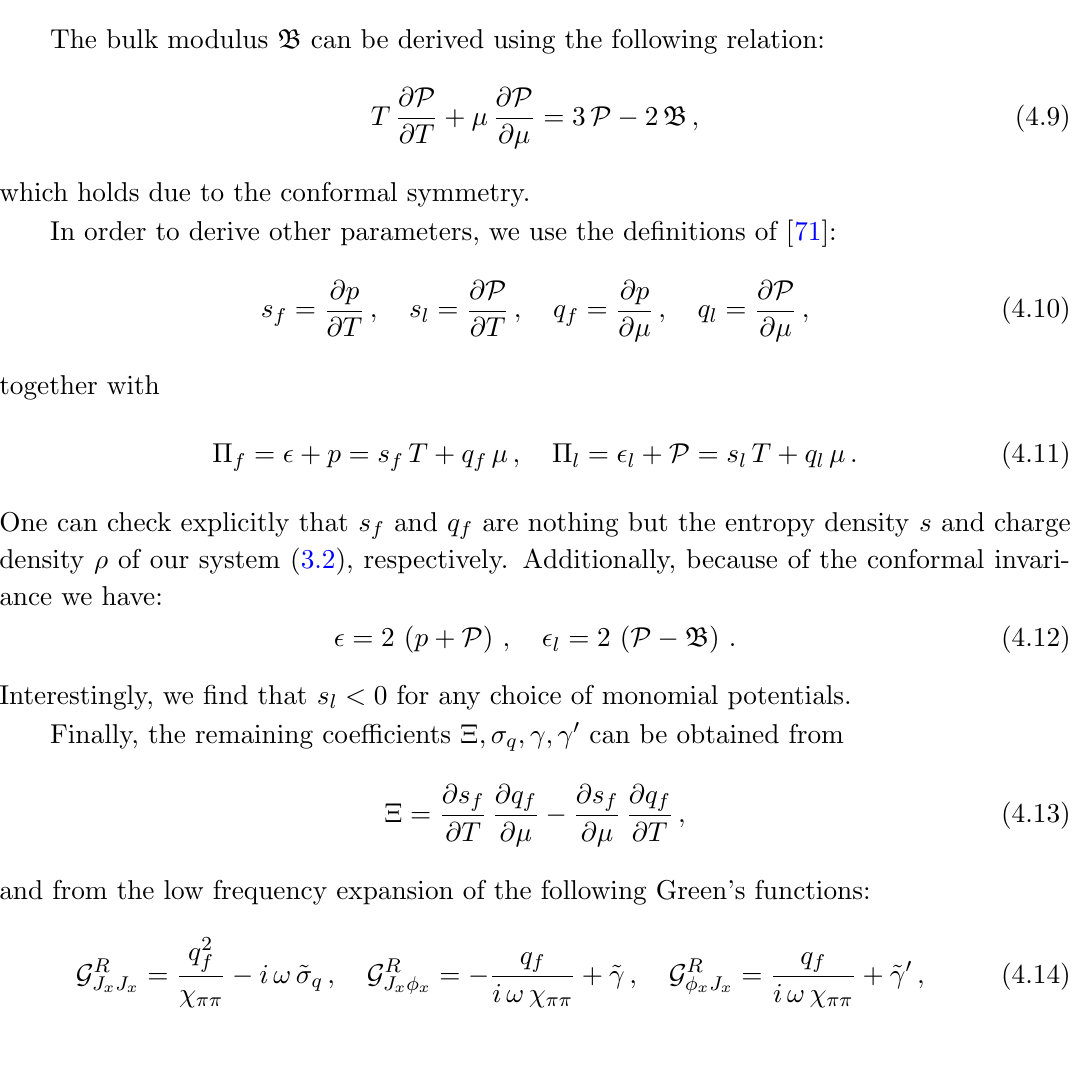
Figure 4 . The analysis of the h (cid:8)(cid:8) i correlator for a benchmark potential V ( X ) = m 2 X 3 at zero magnetic (cid:12)eld. The structure follows the hydrodynamic expectations shown in eq. (4.7). For simplicity we show only one set of data where we keep m = 1 ; u h = 1 (cid:12)xed. Left: Comparison between the momentum susceptibility (cid:31) (cid:25)(cid:25) extracted from the numerical correlator (blue dots) and the hydrodynamic formula (orange line). Right: Comparison between the dissipative coe(cid:14)cients (cid:24) (which relates to (cid:27) ) extracted from the numerical correlator (blue dots) and the hydrodynamic formula (orange